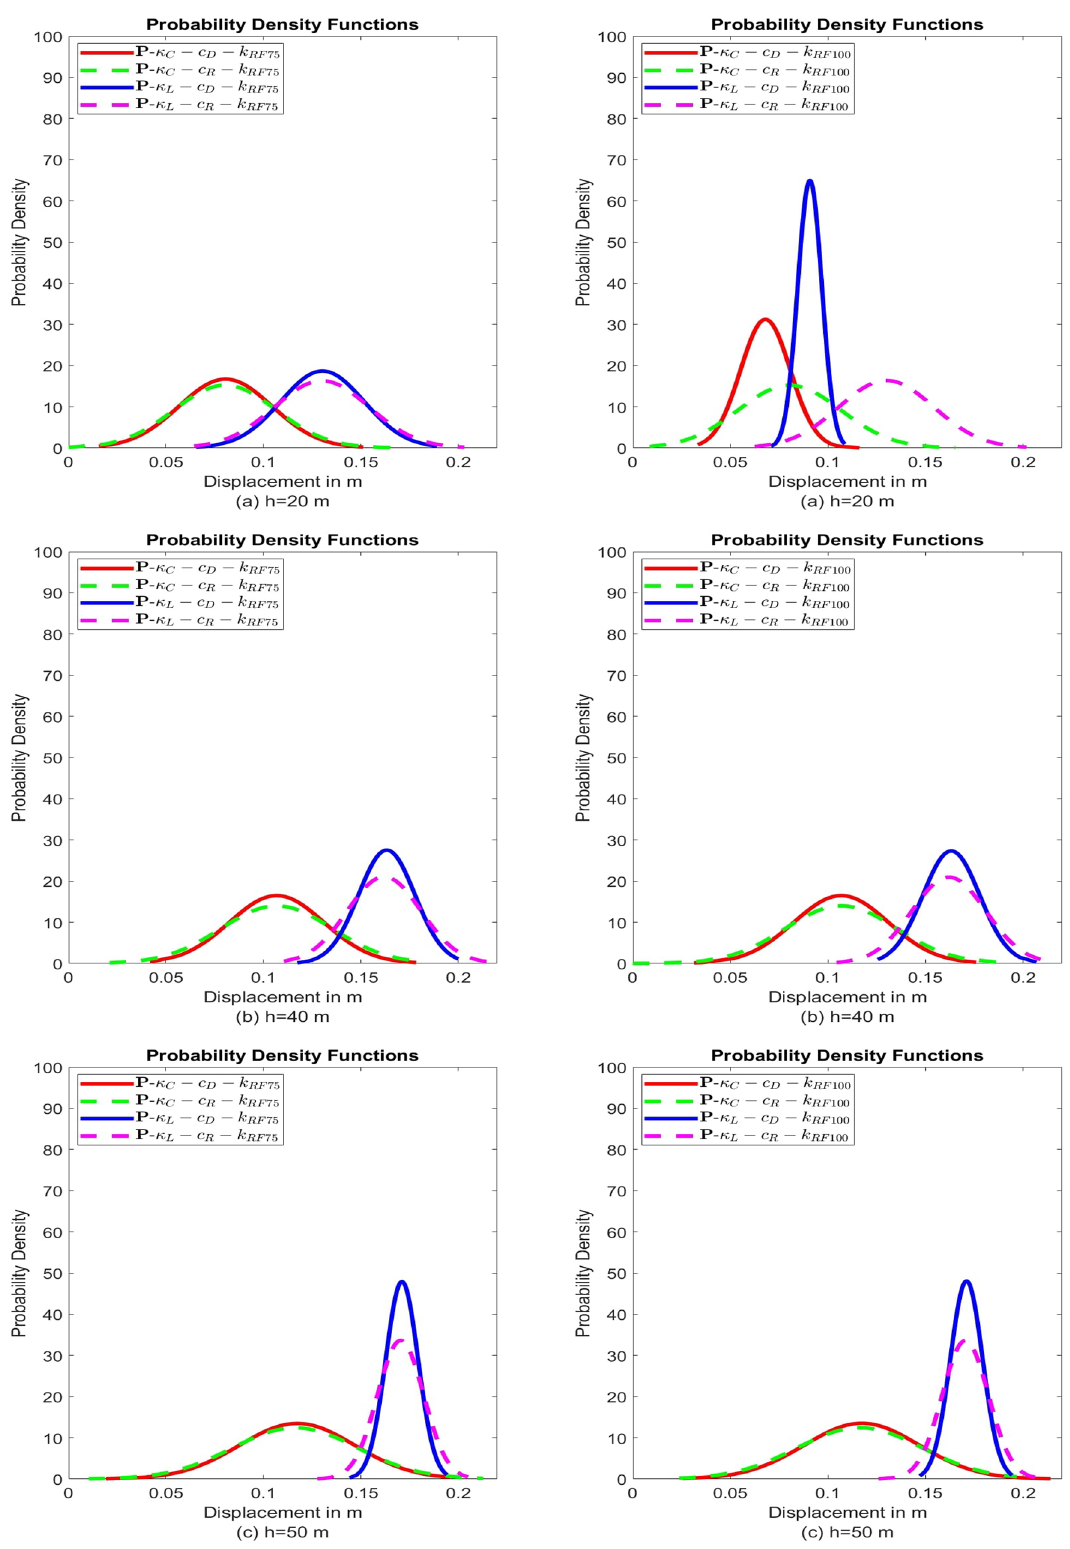
Fig. 10 PDFs of failure displacements of porous analyses with linear and constant distribution for